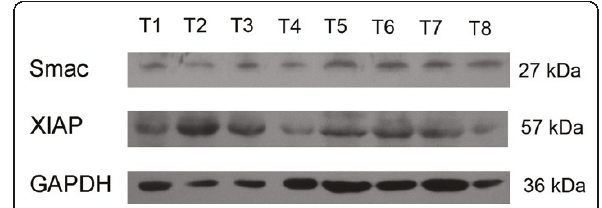
Figure 4 XIAP and Smac proteins in IDC (T1-T8) assessed by Western blot analysis . GAPDH served as internal control of protein loading. Expression of XIAP was more stronger than Smac in IDC with semi-quantitation analysis.